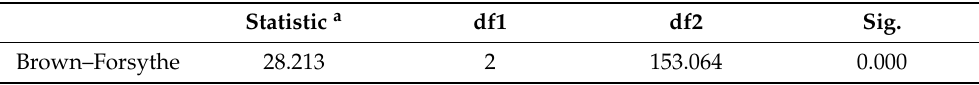
Table 3. Robustness tests of the equality of